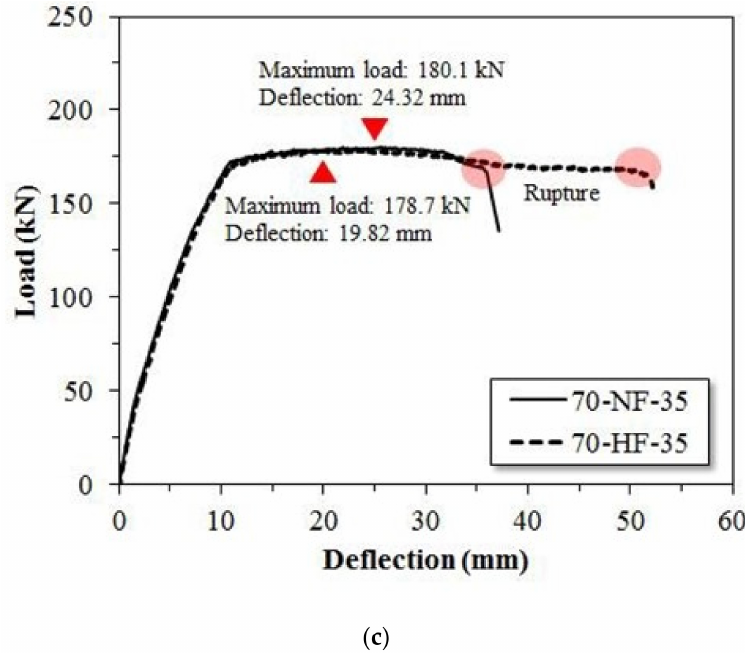
Figure 5. Effects of tensile strength of steel fiber on the load–displacement relationship of SFRC